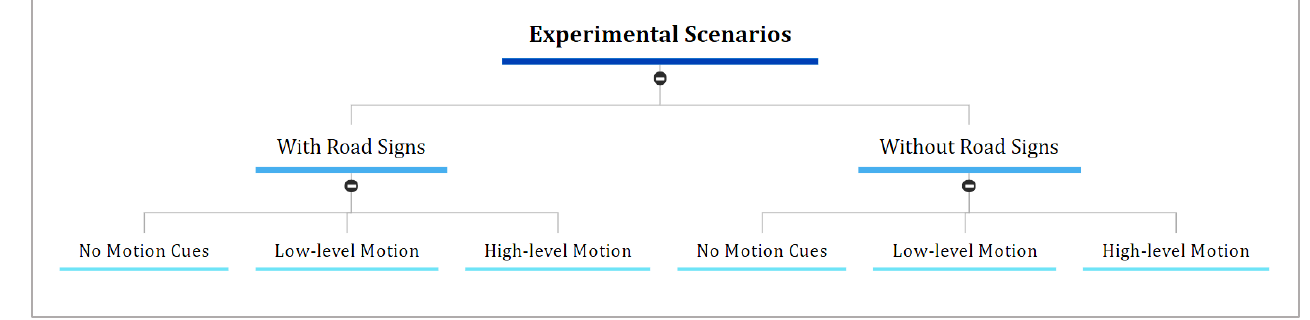
Figure 5. Summary of the six tasks’ conditions based on a combination of different track designs and motion cues levels used in our experiment.